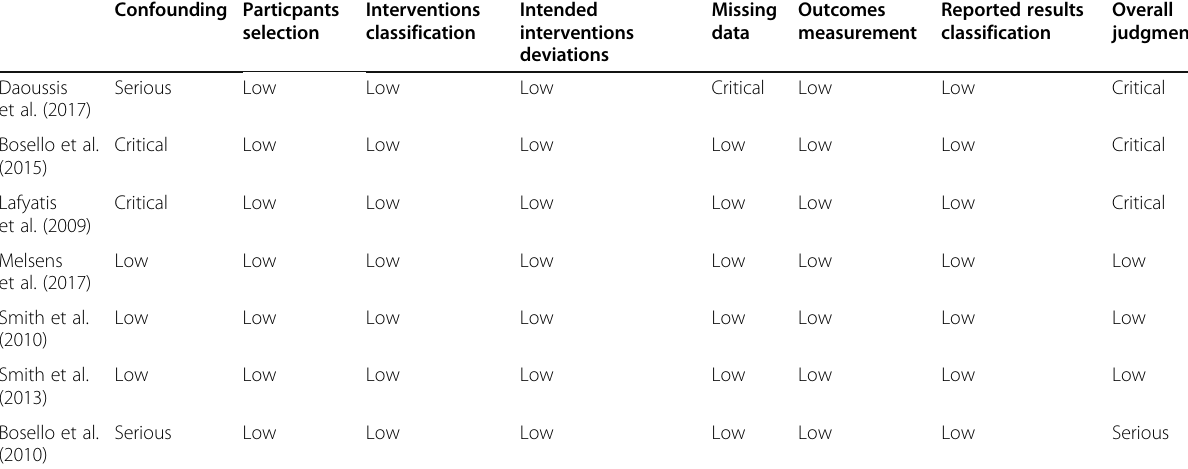
Table 5 Risk of bias in Non-RCTs (ROBINS-I) Confounding Particpants selection